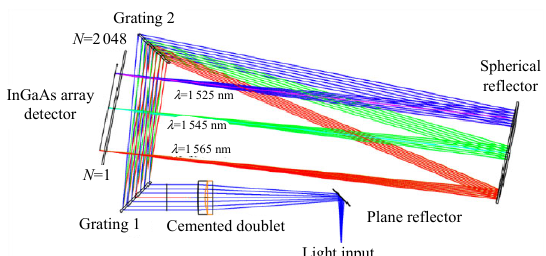
Fig. 2 System simulation of two transmission VBGs based